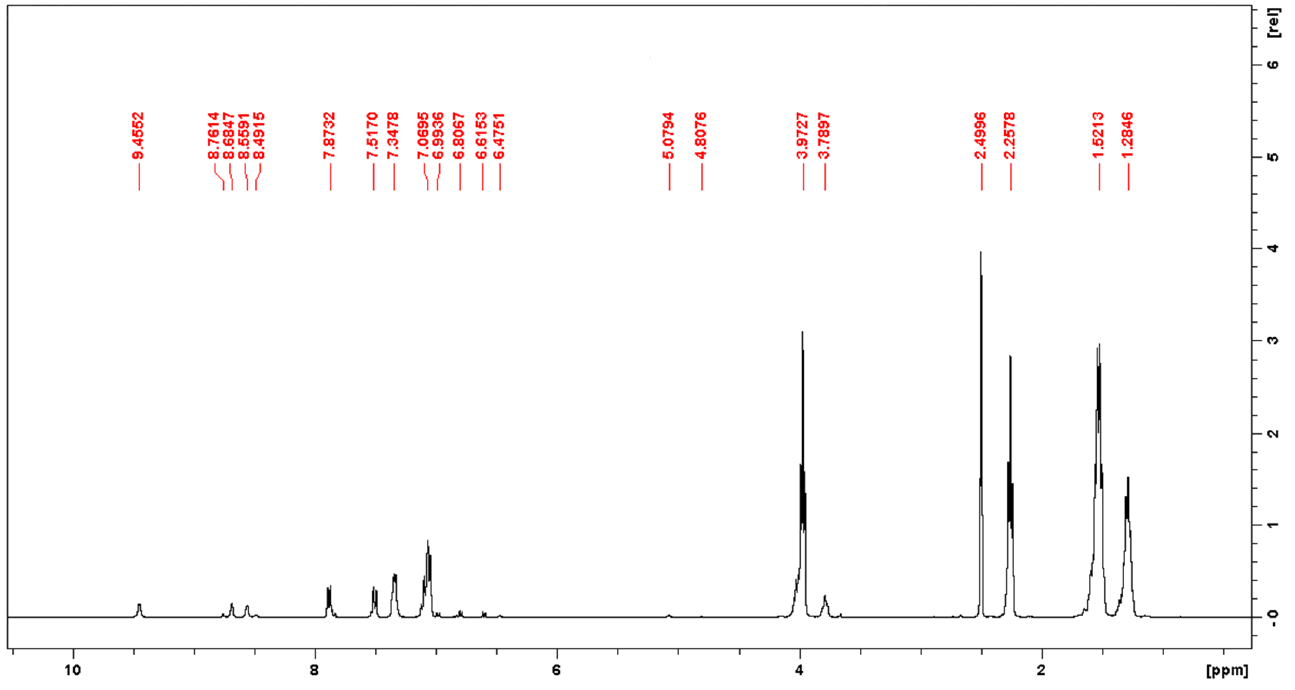
Figure 5. 1 H NMR spectrum of a multiblock PUU with composition S8.